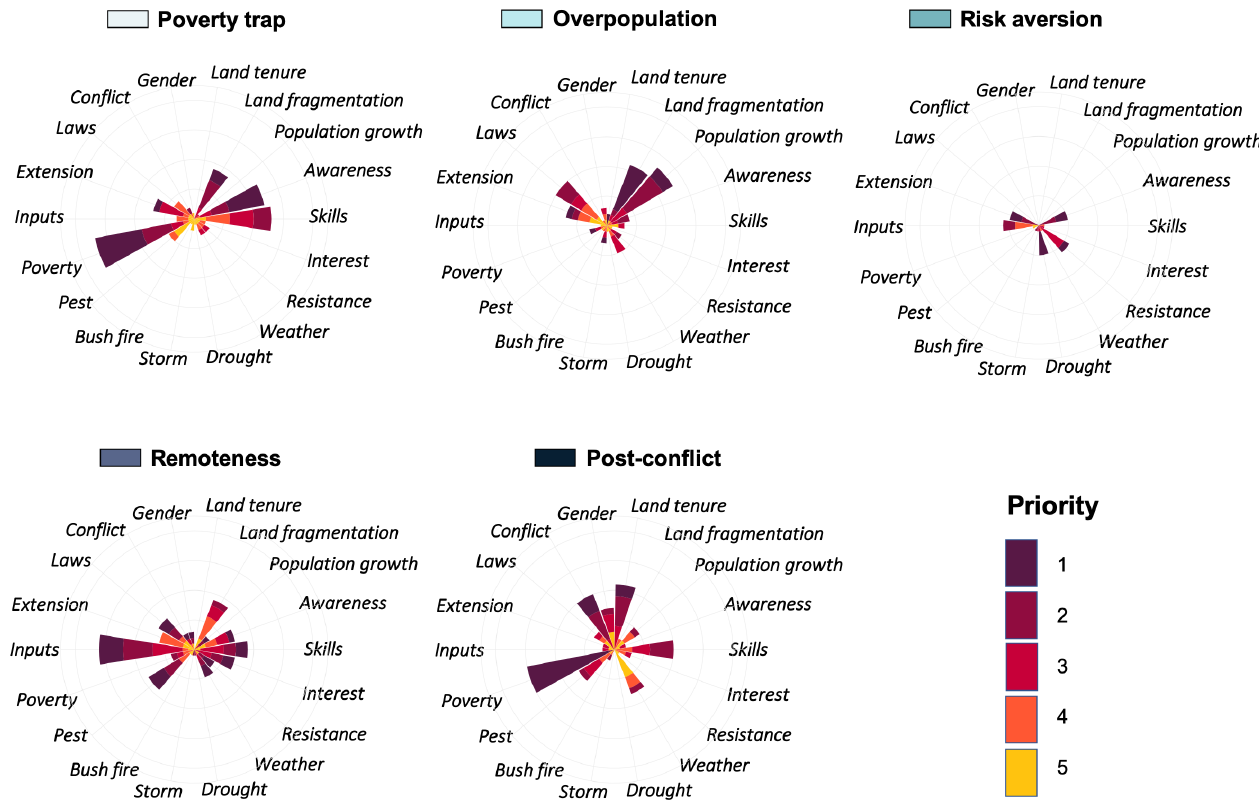
Fig. 4. Cognitive archetypes of barriers for sustainable land and water management adoption. The color gradation indicates the level of priority, with dark red (1) highest and yellow (5) lowest, as expressed by